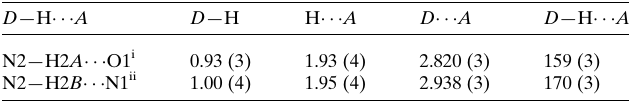
Table 1 Hydrogen-bond geometry (A˚ , (cid:5) ).